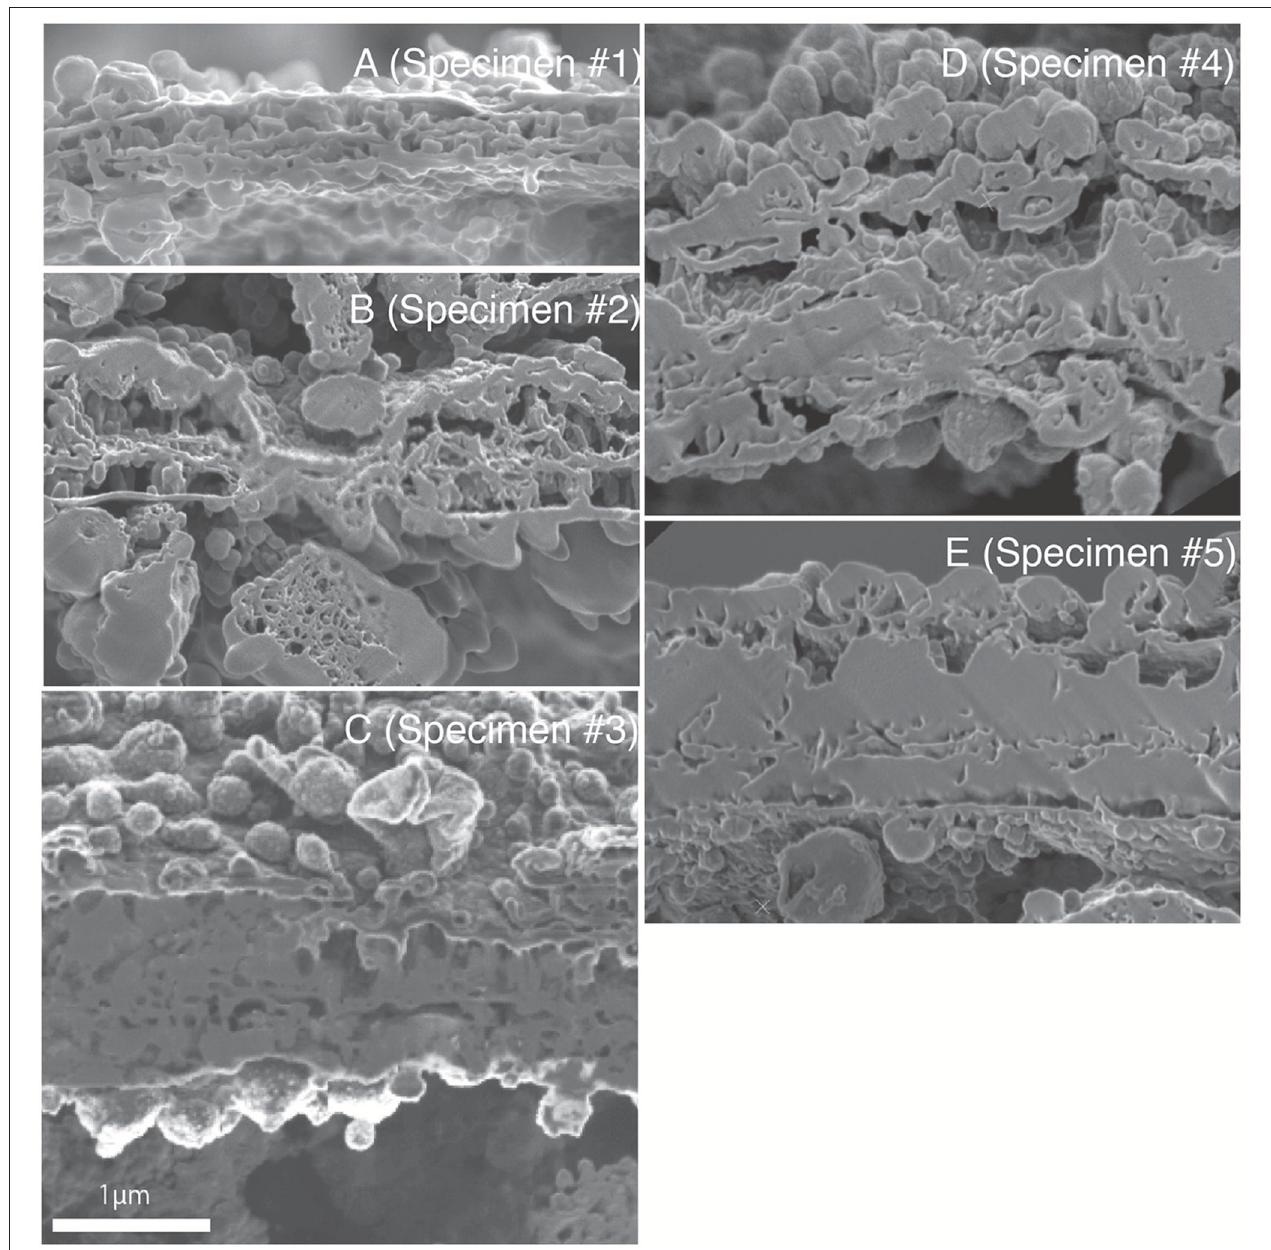
FIGURE 7 | The SEM image of the SOC on the same magnification of all observed specimens. ( A–E ) corresponding to Specimen #1 to #5, respectively.